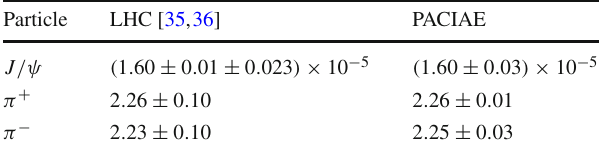
Table 1 The yield of π ± and J /ψ in pp collisions at simulated by the PACIAE model, and compared with experimental data [35,36], with the | y | < 0 . 5, 0 . 1 < p T < 3 GeV/c for π ± and 2 . 0 < y < 4 . 5, 0 < p T < 14 GeV/c for J /ψ , respectively. Here, J /ψ